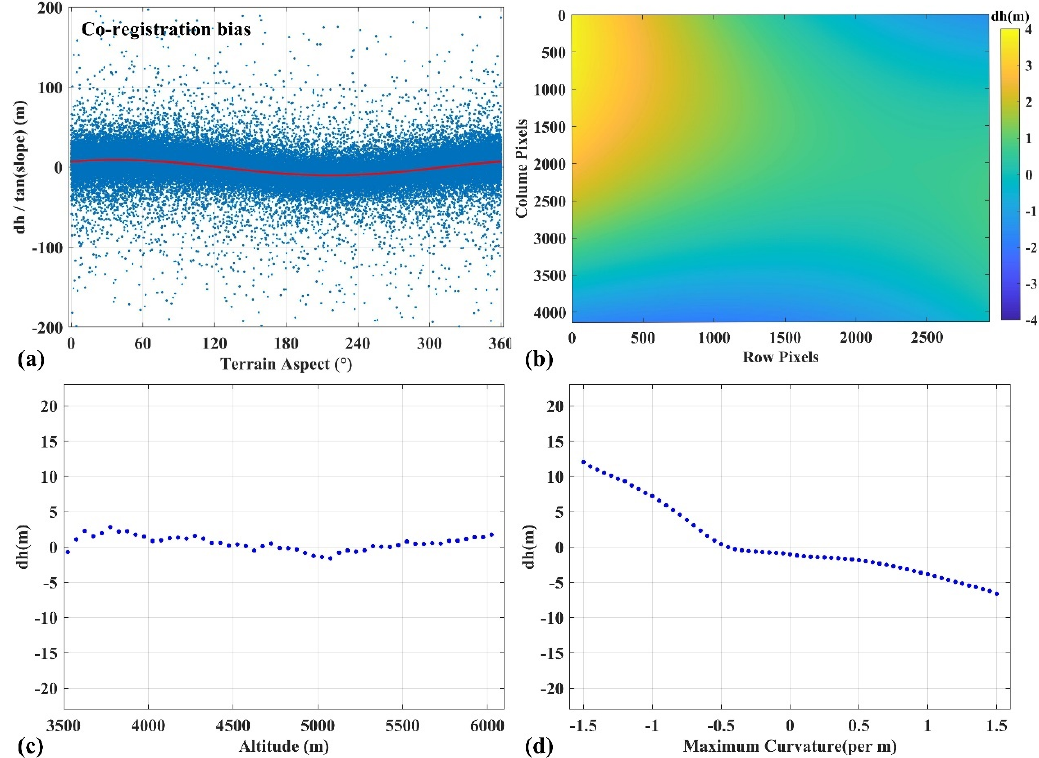
Figure 5. Universal bias trends fitted for elevation difference over stable region (TanDEM-X DEM–SRTM-C DEM). Subfigure ( a ) represents the distribution of normalized elevation differences over stable regions against terrain aspect before DEM co-registration. Red curves denote the regressed cosine function. Subfigures ( b ), ( c ) and ( d ) represent the distribution of biases related to planimetric position, altitude and terrain curvature, respectively. Table 3. Statistical results of elevation difference in stable regions before and after DEM co-registra- tion and systematic bias correction.